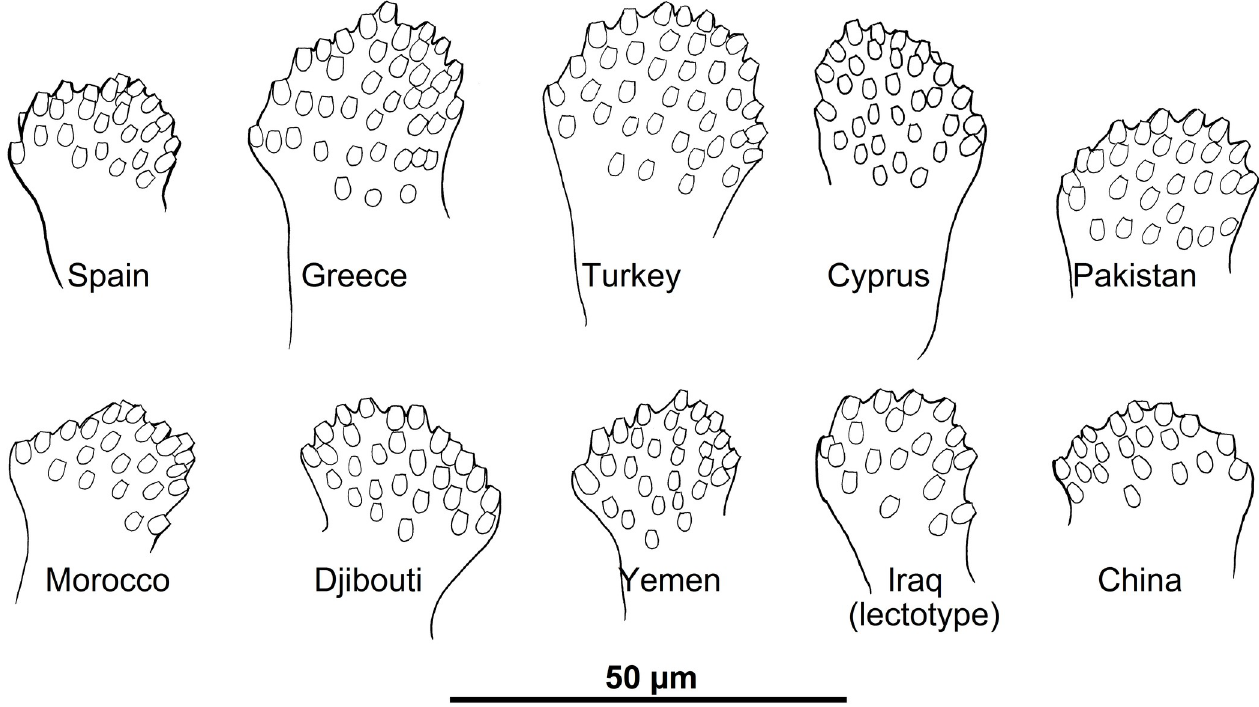
Fig 5. Morphological variability of the basal lobe of the gonocoxite of Ph . alexandri specimens collected in different localities. Drawings by J. Depaquit.